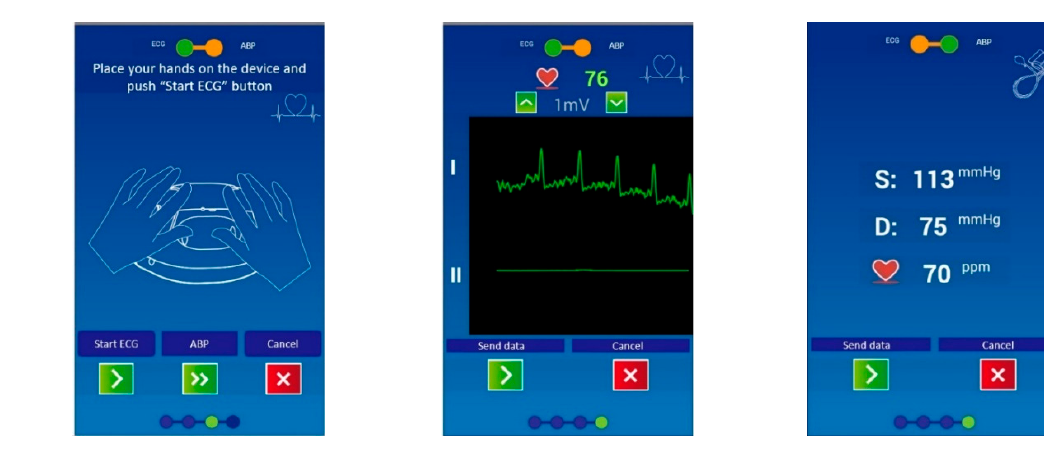
Figure 5. App flow block diagram.